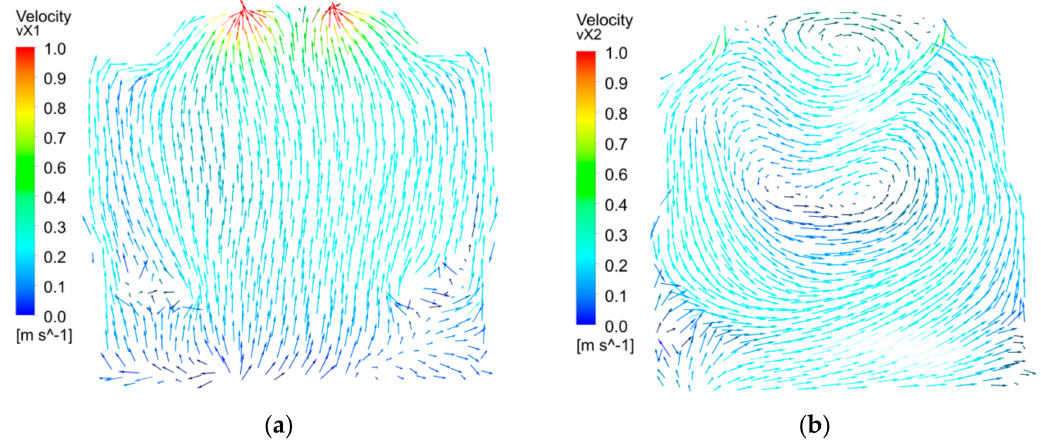
Figure 5. Velocity fields, case 1, plane X1 ( a ) and plane X2 ( b